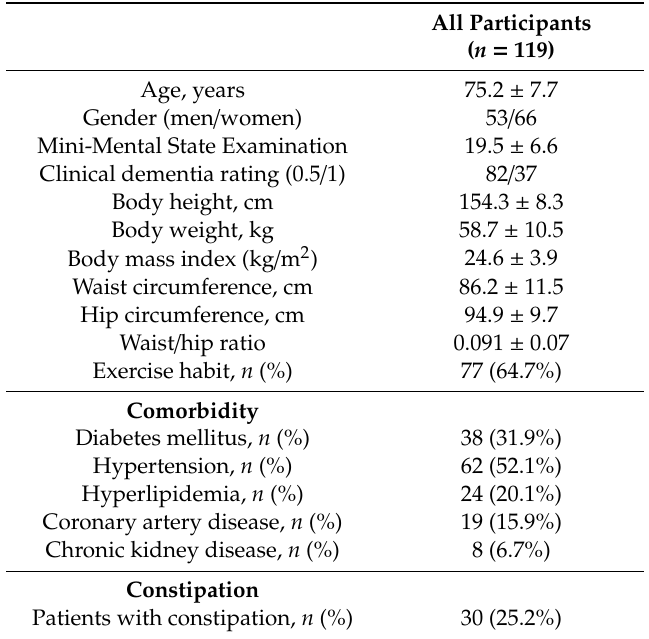
Table 1. Demographic and clinical characteristics of patients with